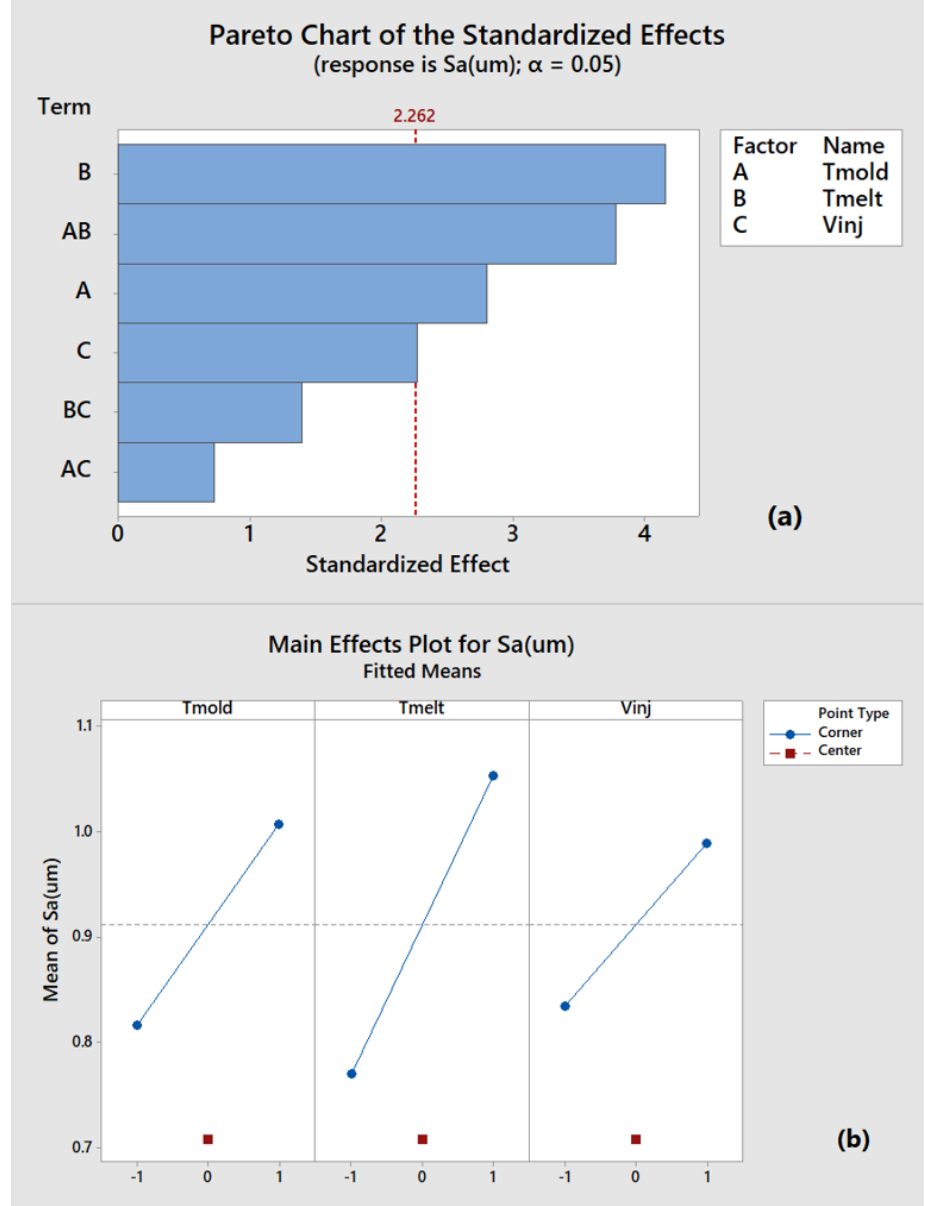
Figure 12. Pareto chart ( a ) and main-effect plots ( b ) of process parameters by Sa.